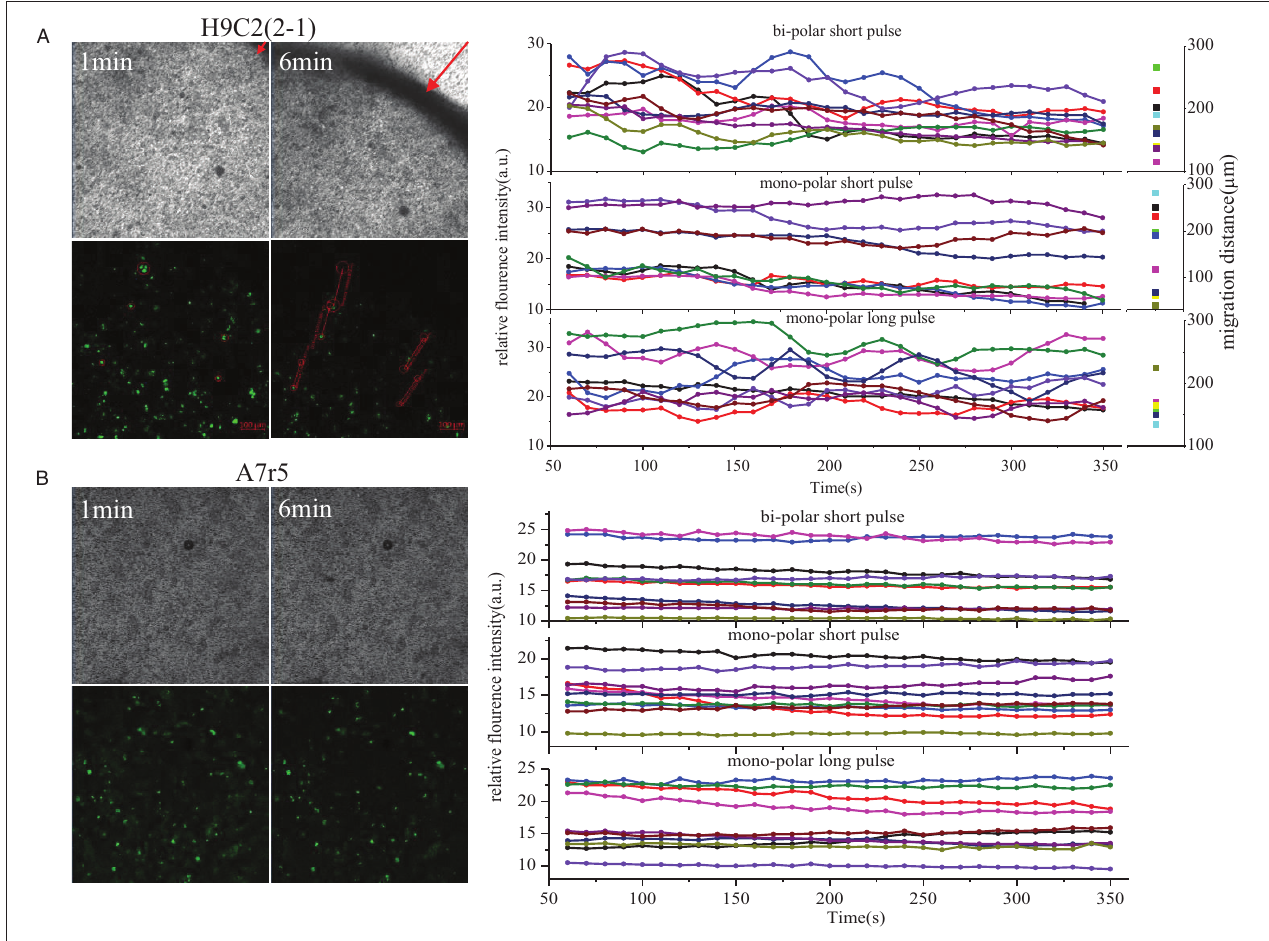
FIGURE 2 | Ca 2 + influx in H9C2(2-1)and A7r5 after PFA. (A) H9C2(2-1). (B) A7r5. PFA, pulsed-field